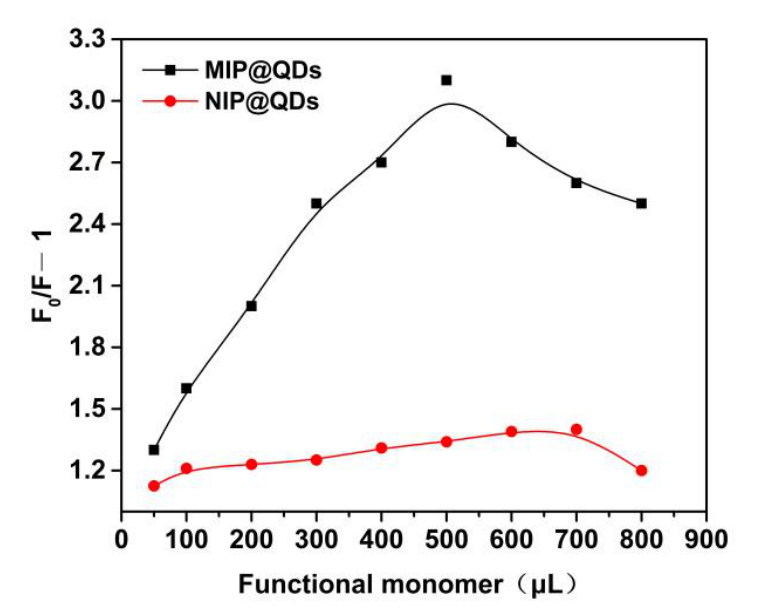
Figure 4. Effects of the amount of the functional monomer MAA (mg) on fluorescence quenching of MIP@QDs and NIP@QDs.